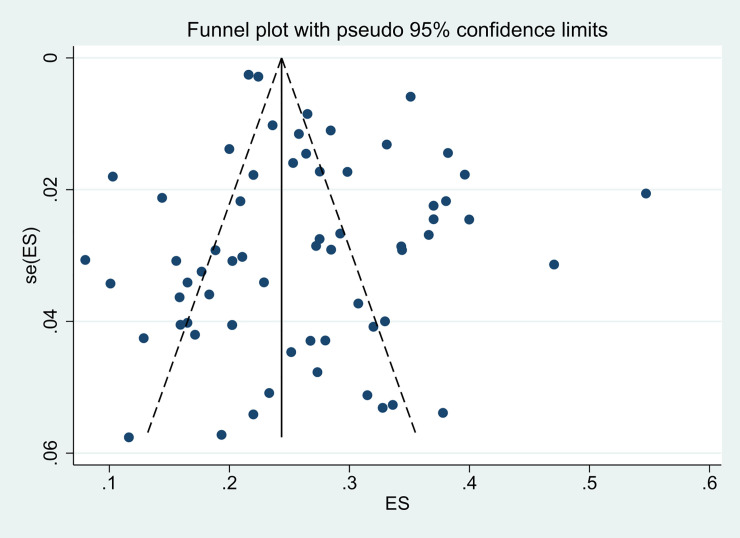
Funnel plot of publication bias.